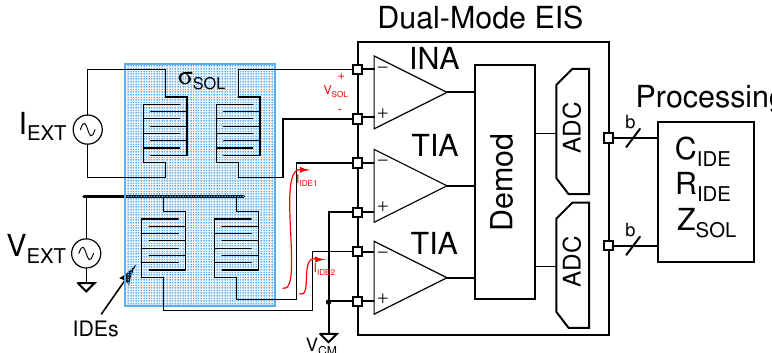
Figure 1. Conceptual arrangement of a dual-mode EIS measurement system with arrays of interdigitated electrodes (IDEs) to measure solution impedance and electrode/interface impedance. The solution impedance can be measured using a tetrapolar configuration by injecting a differential current, I EXT , through an electrode and measuring the differential voltage across a second electrode. Electrode/interface impedance can be measured by exciting an electrode with a voltage source, V EXT , and reading the current flowing through the electrode. In the example in the figure, the same external source is used on multiple electrodes.